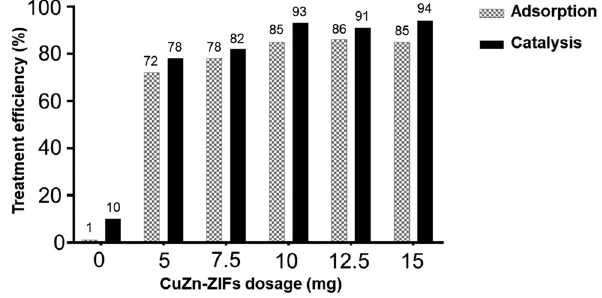
Figure 4: E ff ect of material dosage on the DBF removal e ffi ciency. Catalysis: [ DBF ] = 30ppm, [ H 2 O 2 ] = 15mM. Adsorption: [ DBF ] = 30ppm, room temperature, time = 60min.